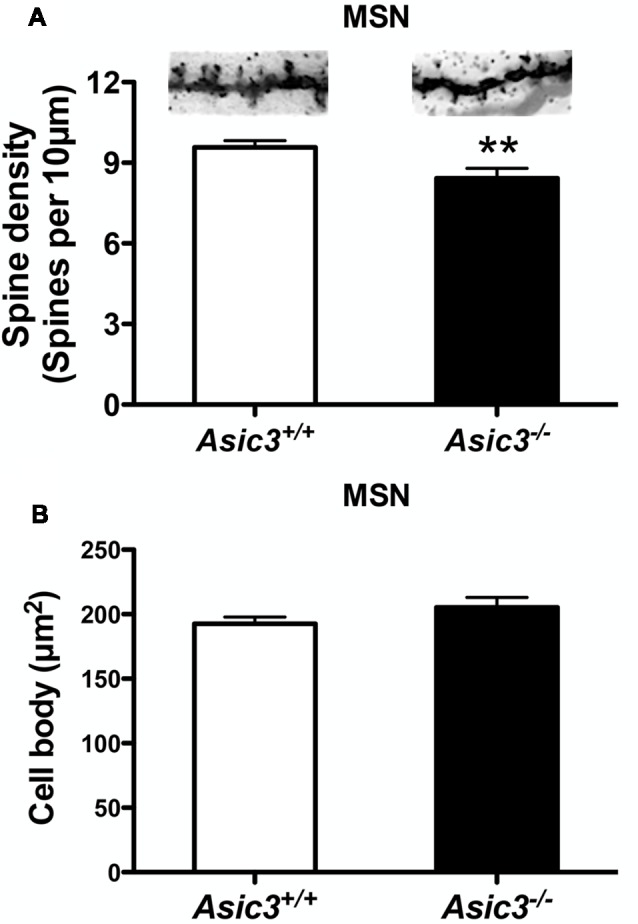
The effect of Asic3 knockout on dendritic spines of striatal medium spiny neurons (MSNs). (A) The dendritic spine density of MSNs was lower in Asic3−/− mice than in Asic3+/+ mice (Asic3+/+
n = 108 spines from six mice, Asic3−/−
n = 83 spines from five mice, t = 2.670 df = 189, p = 0.0082 by two-tailed t-test). **p < 0.01 vs. Asic3+/+. (B) No difference in MSNs cell body size between two genotypes (Asic3+/+
n = 118 spines from six mice, Asic3−/−
n = 92 from five mice). Data are mean ± SEM. Data analyzed by two-tailed unpaired t-test.